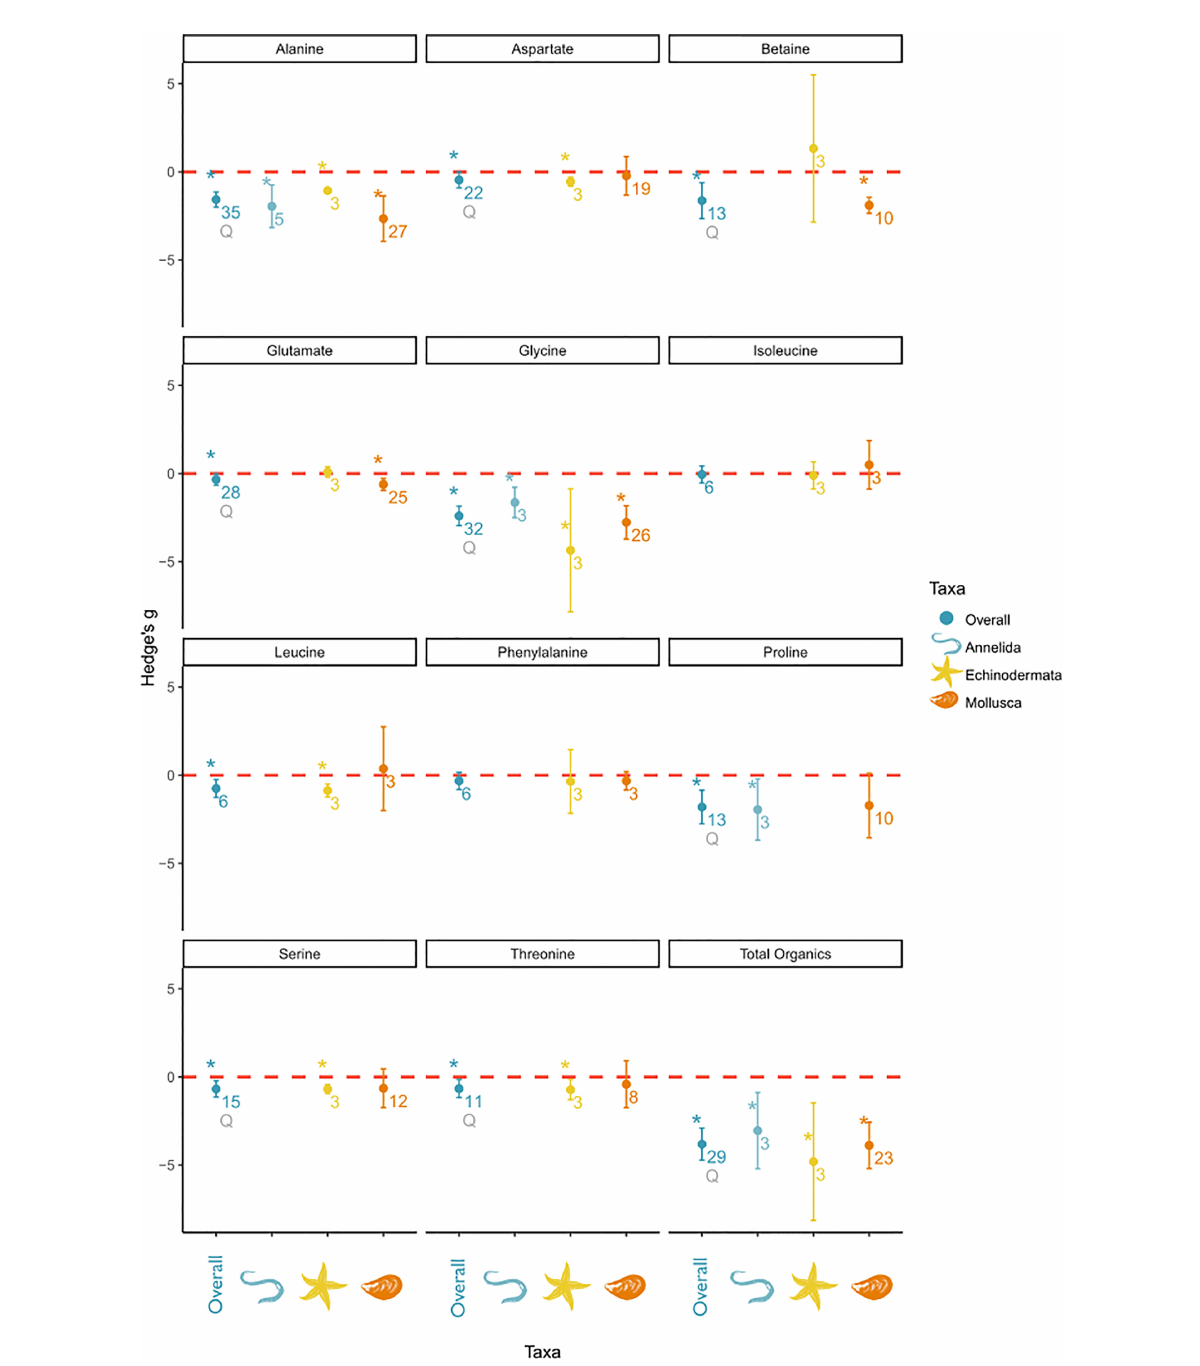
FIGURE 5 Subgroup analysis of salinity effects on organic osmolyte concentrations in tissue by taxa. The panel includes a separate plot, for each measured solute. In each plot the overall effect and the subgroups are depicted on the x-axis and the effect sizes as Hedge ’ s g on the y-axis. A positive value indicates a positive salinity effect (i.e., an increase in concentration at decreasing salinities), whereas a negative value indicates a negative salinity effect on solute concentration. The overall mean effect size might differ from Figure 4 due to changed sample size when subgroups could not be included due to small sample size. The mean effect size for each taxon is depicted as a circle with the error bars indicating robust con fi dence intervals (95%). An asterisk above the overall effect size indicates taxon af fi liation as a signi fi cant moderator. Asterisks above the individual taxa indicate a signi fi cant salinity effect for that speci fi c subgroup. Numbers below circles indicate k — the number of studies. Q indicates signi fi cant residual heterogeneity as tested with the mixed effects